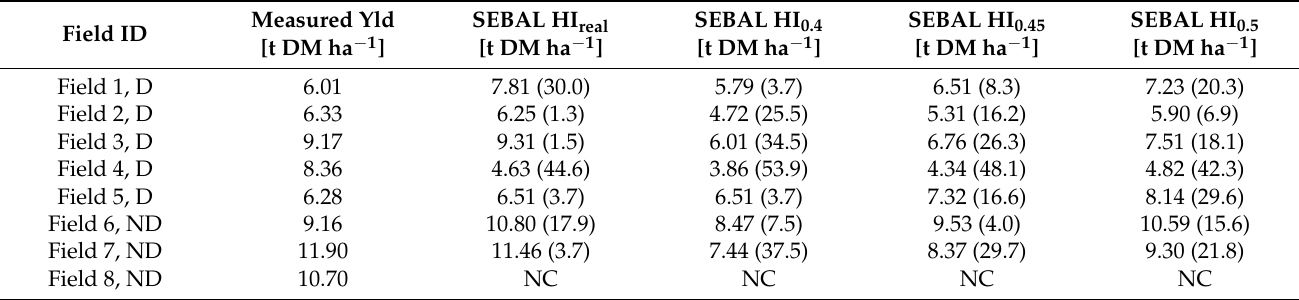
Table 2. Comparison between measured yield and SEBAL-estimated yield using the actual (SEBAL HI real ) and literature harvest index (SEBAL HI 0.4 , SEBAL HI 0.45 , SEBAL HI 0.5 ). Values in parenthesis represent the relative error from the measured yield at harvest. NC identifies not calculated SEBAL values.